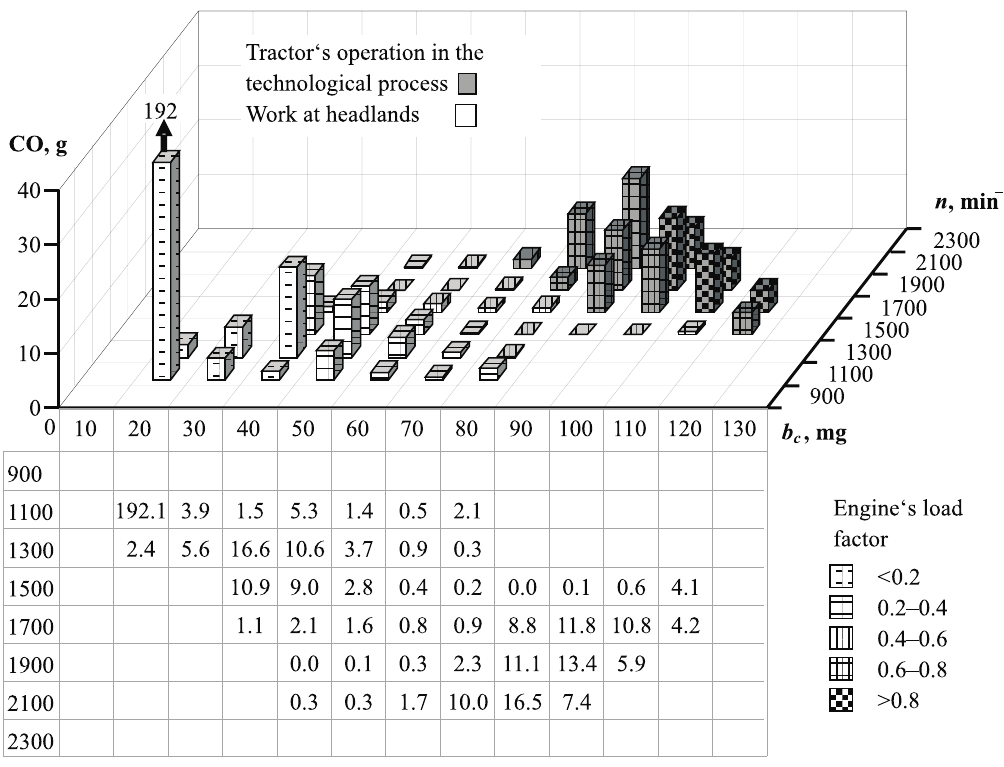
Fig. 10. Distribution of CO emissions during the test period of drilling (3867 s) in the modes of engine speed